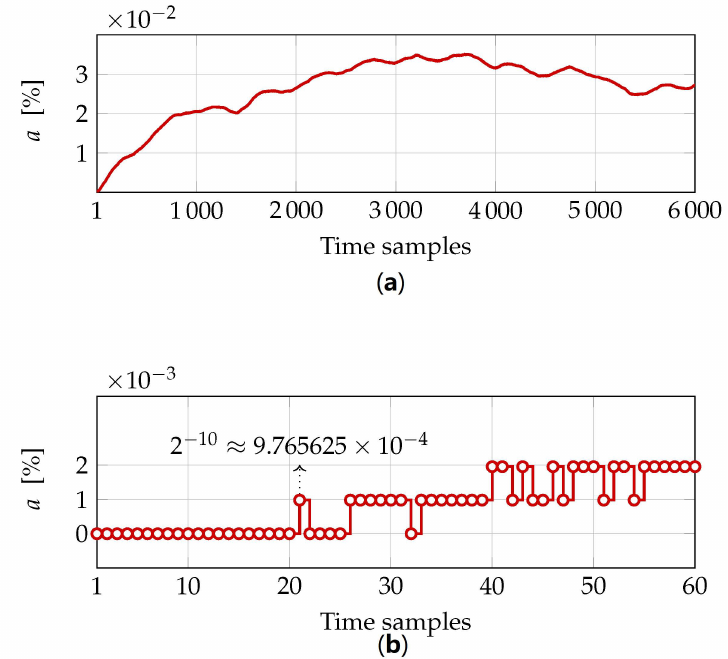
Figure 21. FPGA and MATLAB responses expressed as ( a ) absolute difference and ( b )